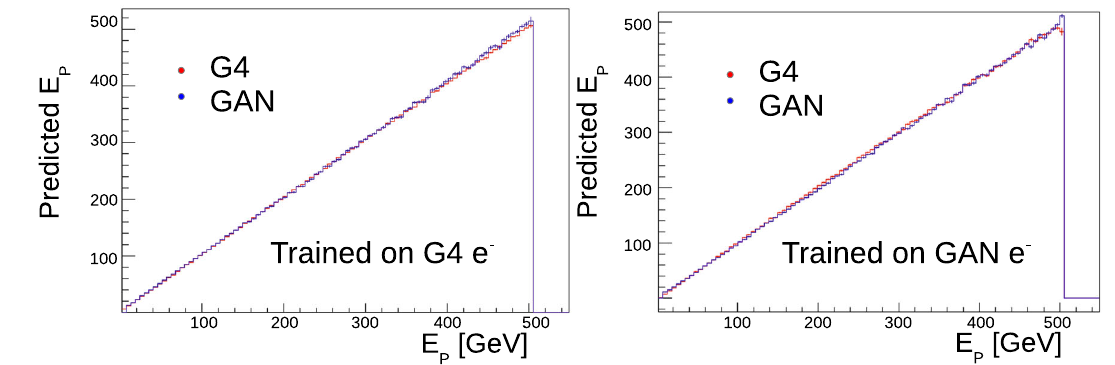
Fig. 20 Performance of the network trained on GEANT4 electrons and charged pions (left) vs. that of the network trained GAN electrons and GEANT4 charged pions (right). The profile plot for true and predicted E P for the GAN and Monte Carlo samples are very similar. There were 9834 events for each type Table 3 Triforce classification results Trained